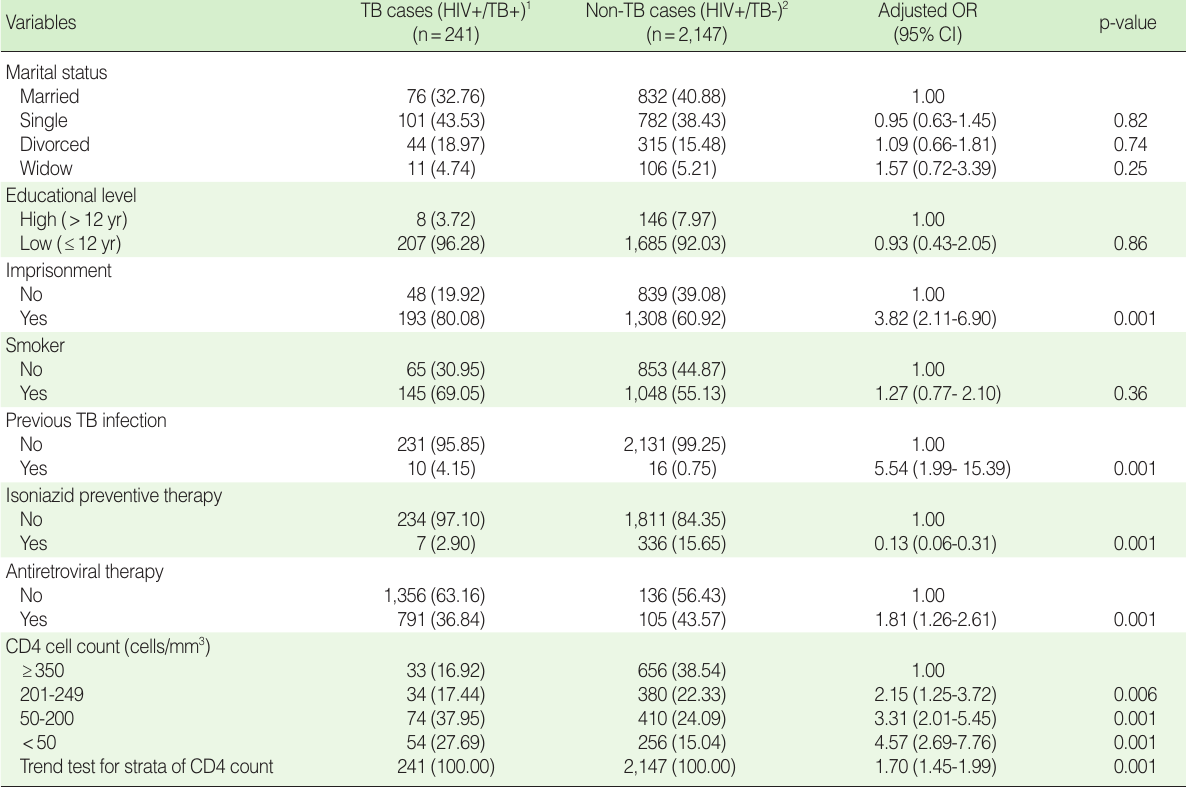
Table 2. Results from the multivariate logistic regression analysis of binary and continuous predictors of M. tuberculosis /HIV co-infection us- ing odds ratios (ORs) adjusted for all other variables in the model (pseudo R 2